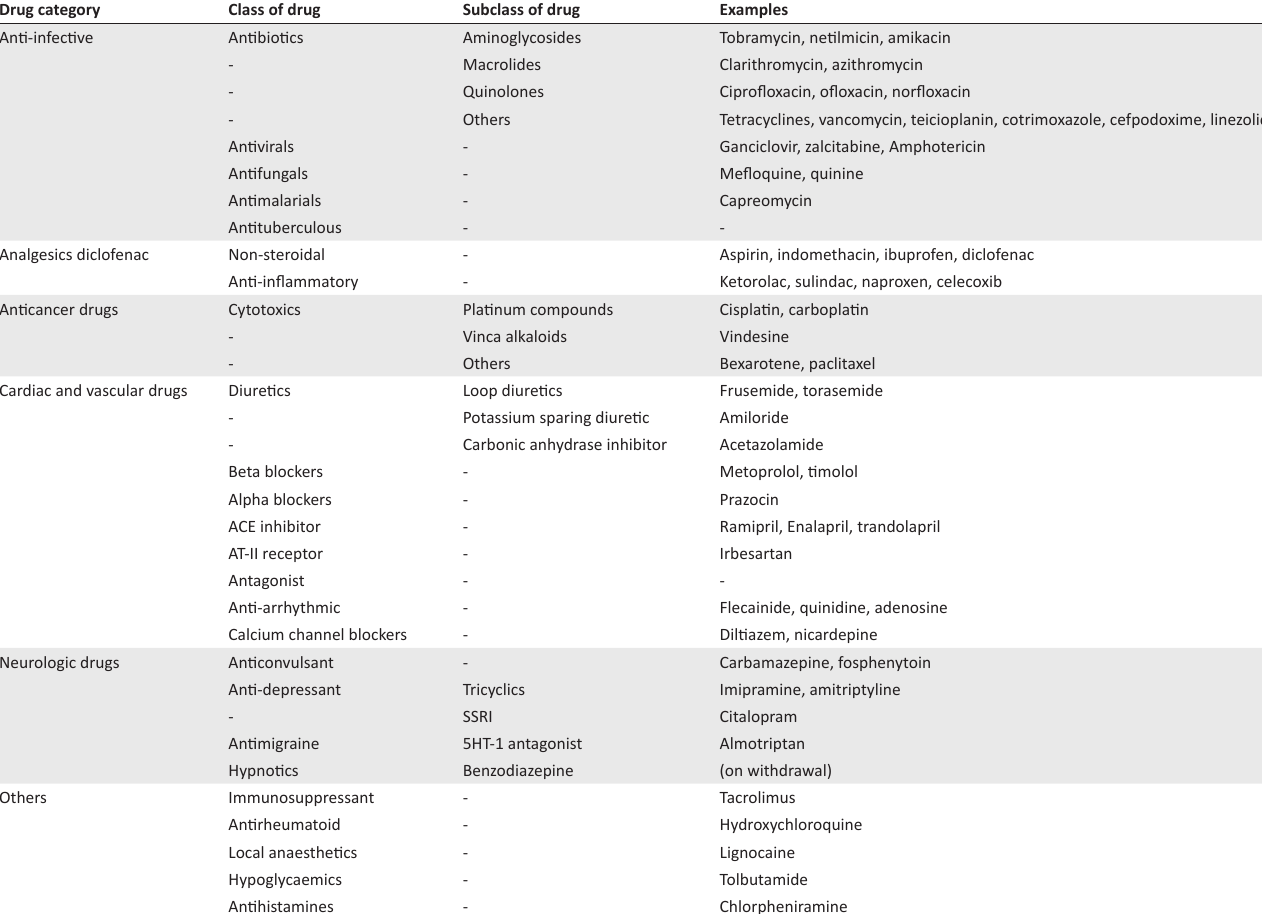
TABLE 2-A1: Drugs causing tinnitus as a side effect. Drug category